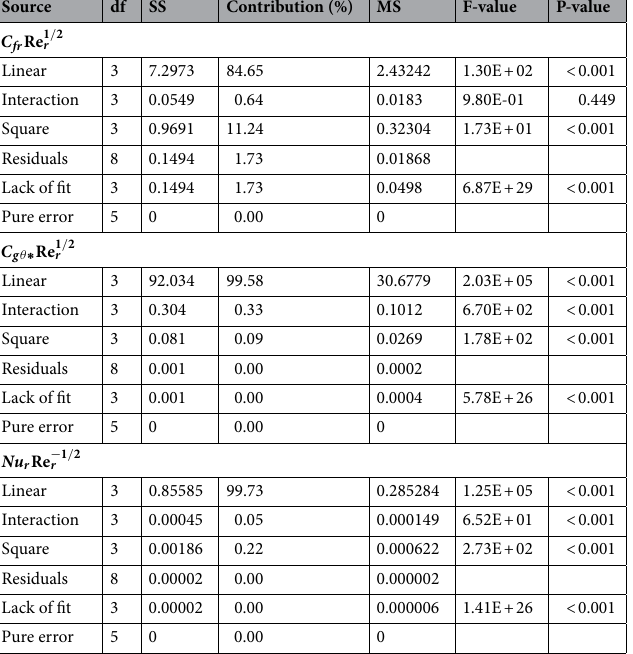
Table 6. ANOVA for skin friction coefficients ( C fr , C g θ which includes the quantification and significance of considered linear, interaction, and square model